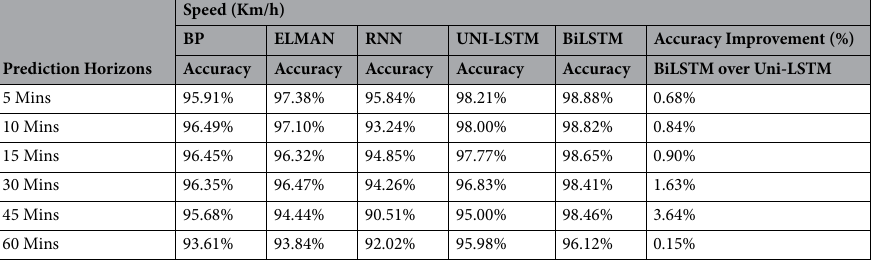
Table 4. Speed performance for different prediction horizons.